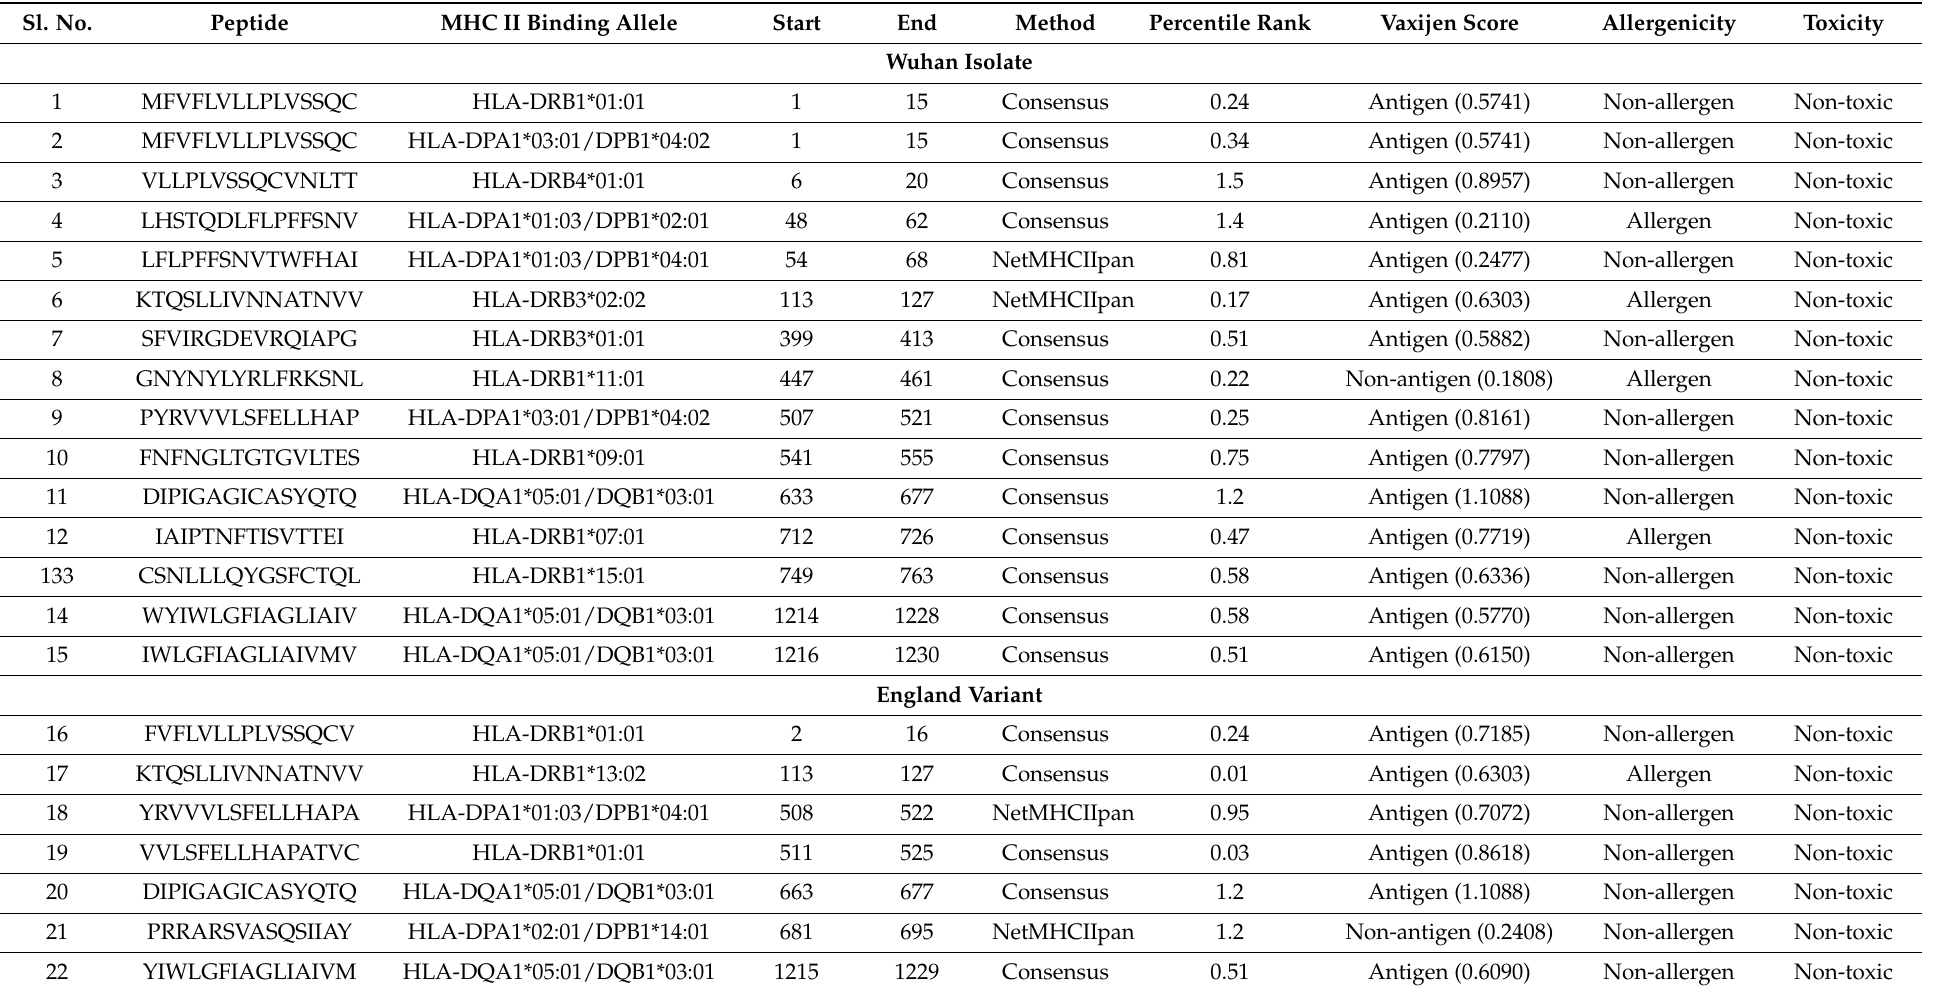
Table 3. List of helper T-cell epitopes with encountering MHC II alleles with their positional, prediction method, antigenicity, allergenicity, and toxicity information. Sl.